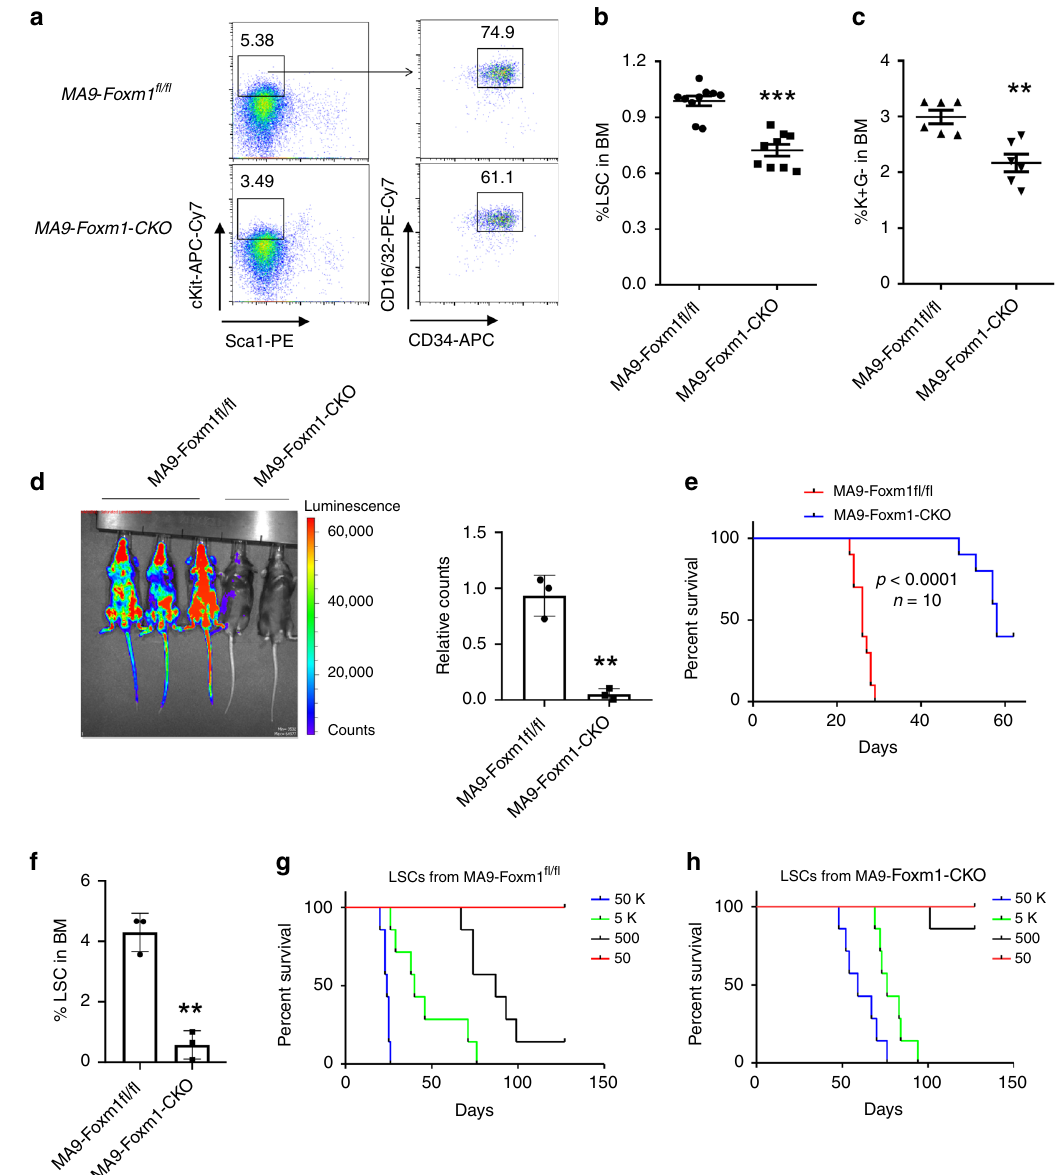
Fig. 3 Foxm1 is critical for the maintenance of MA9-transformed LSCs. a – c Flow cytometric analysis of percentage of LSC (L-GMP: Lin − c-Kit + Sca1